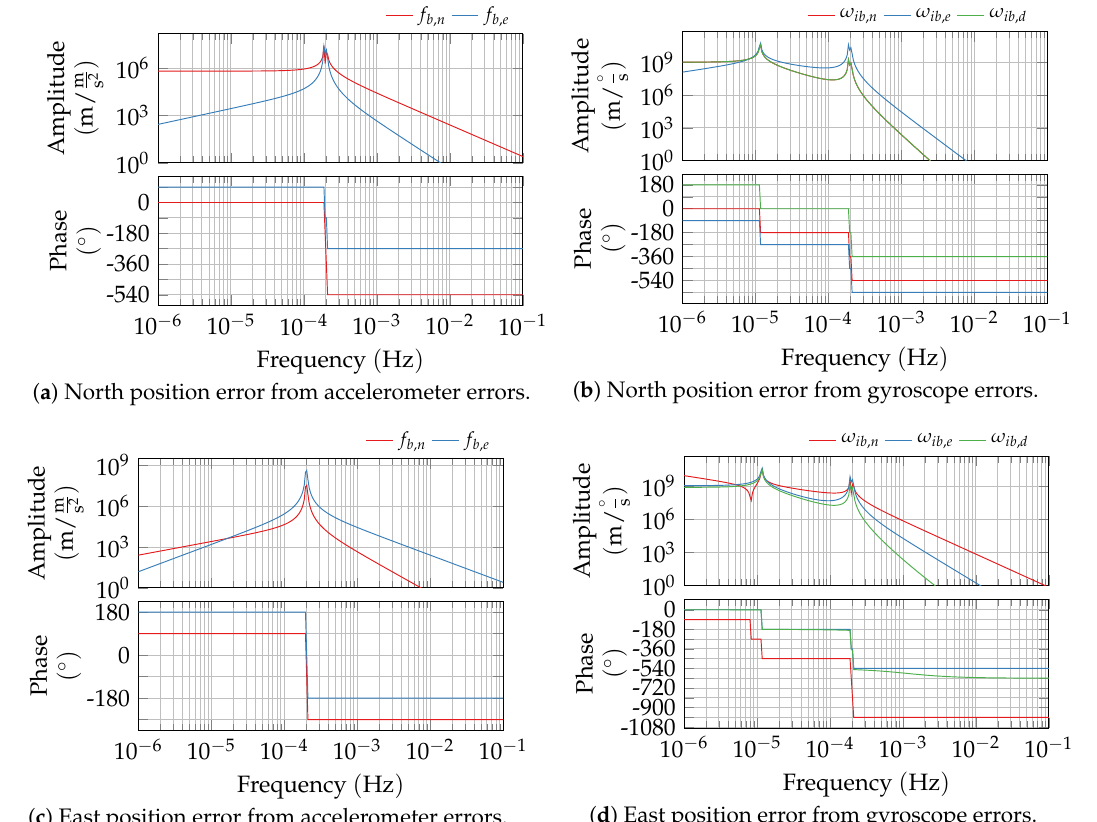
( c ) East position error from accelerometer errors. ( d ) East position error from gyroscope errors. Figure 1. Bode plots of the strapdown error dynamics transfer functions at a geodetic latitude of 45 ◦